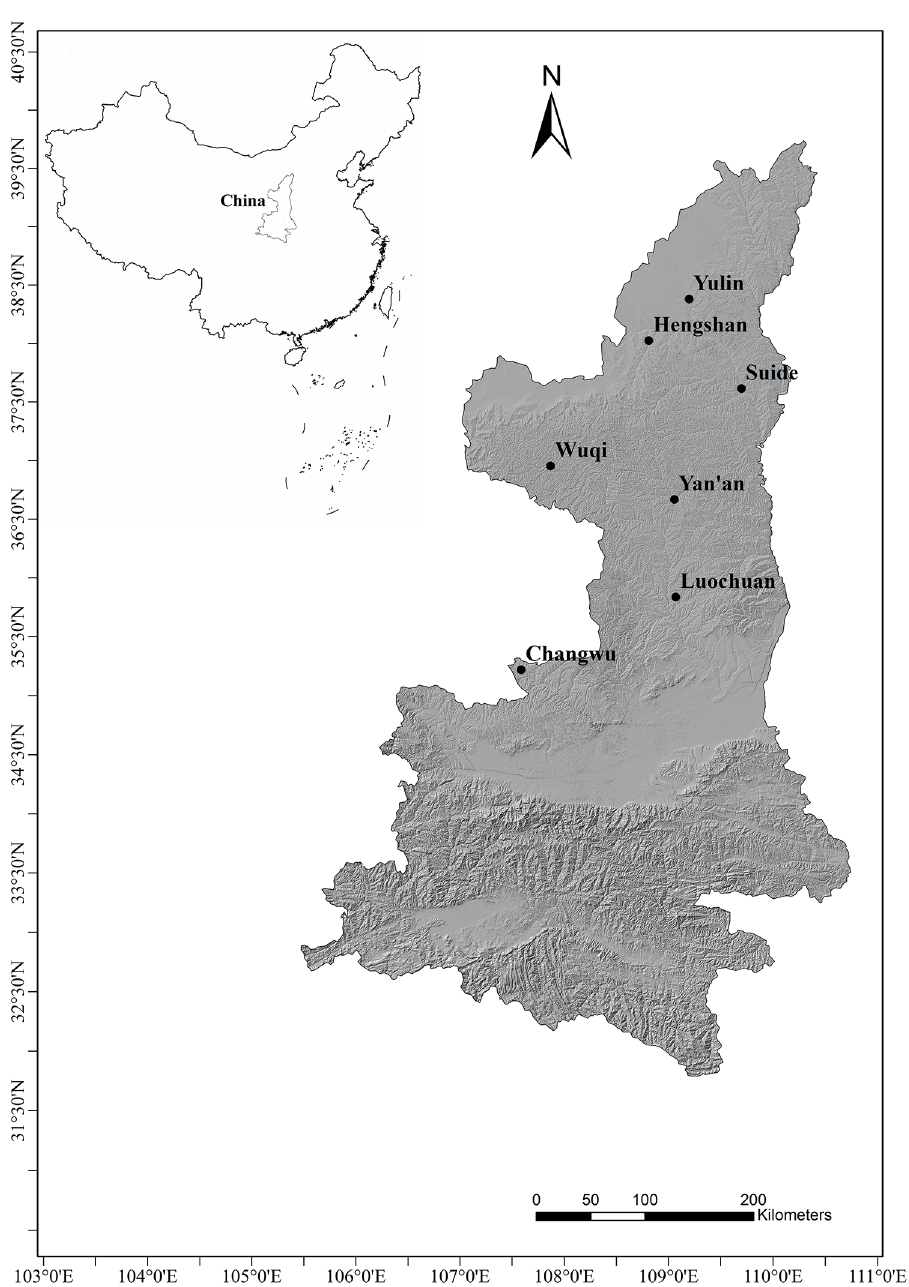
Fig 1. Map of the Spatial distribution of the 7 synoptic stations in the semi-arid region of Northern Shaanxi.